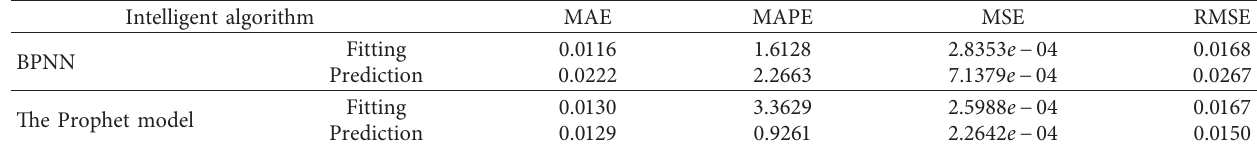
Table 3: The comparison of fitting and prediction results.